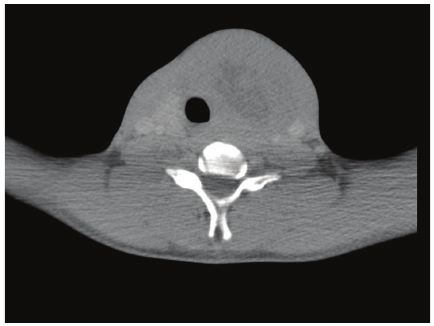
Figure 2: Staging CT showing a large (6.7 cm × 5.8 cm × 6.1 cm) heterogeneous mass in the left lobe and isthmus of the